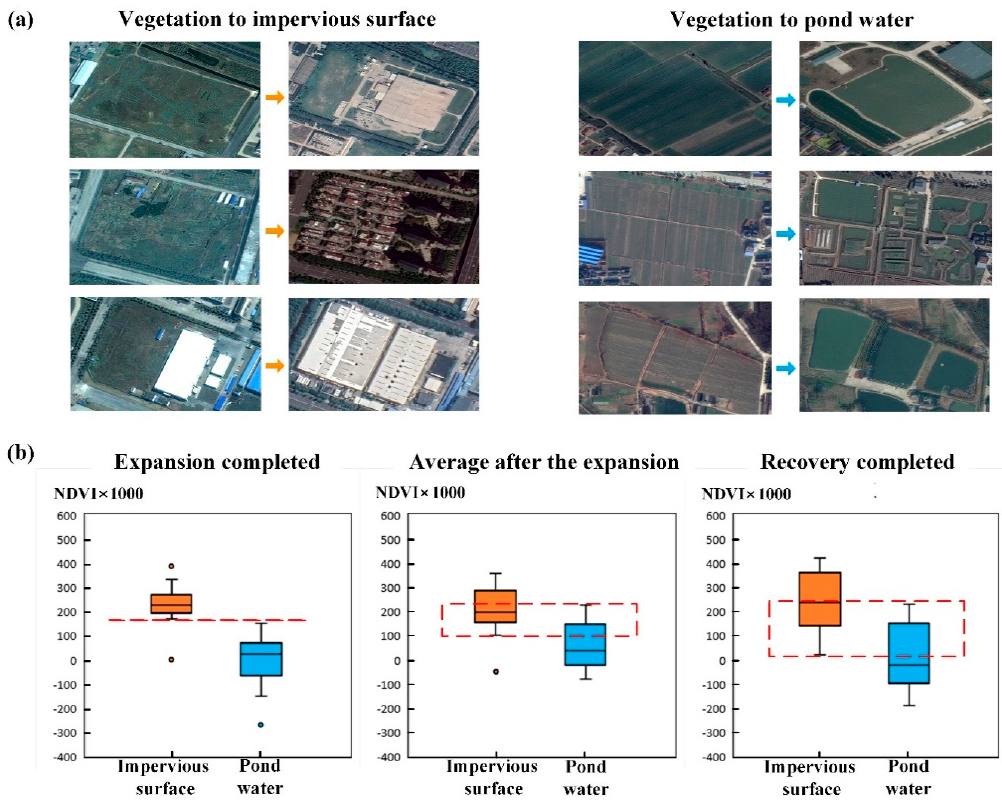
Figure 8. Samples statistics. ( a ) Typical images of conversion from vegetation to impervious surface and vegetation to pond water. ( b ) Separability statistics of three parameters: NDVI upon completion of expansion, average NDVI after expansion, and NDVI upon completion of recovery.